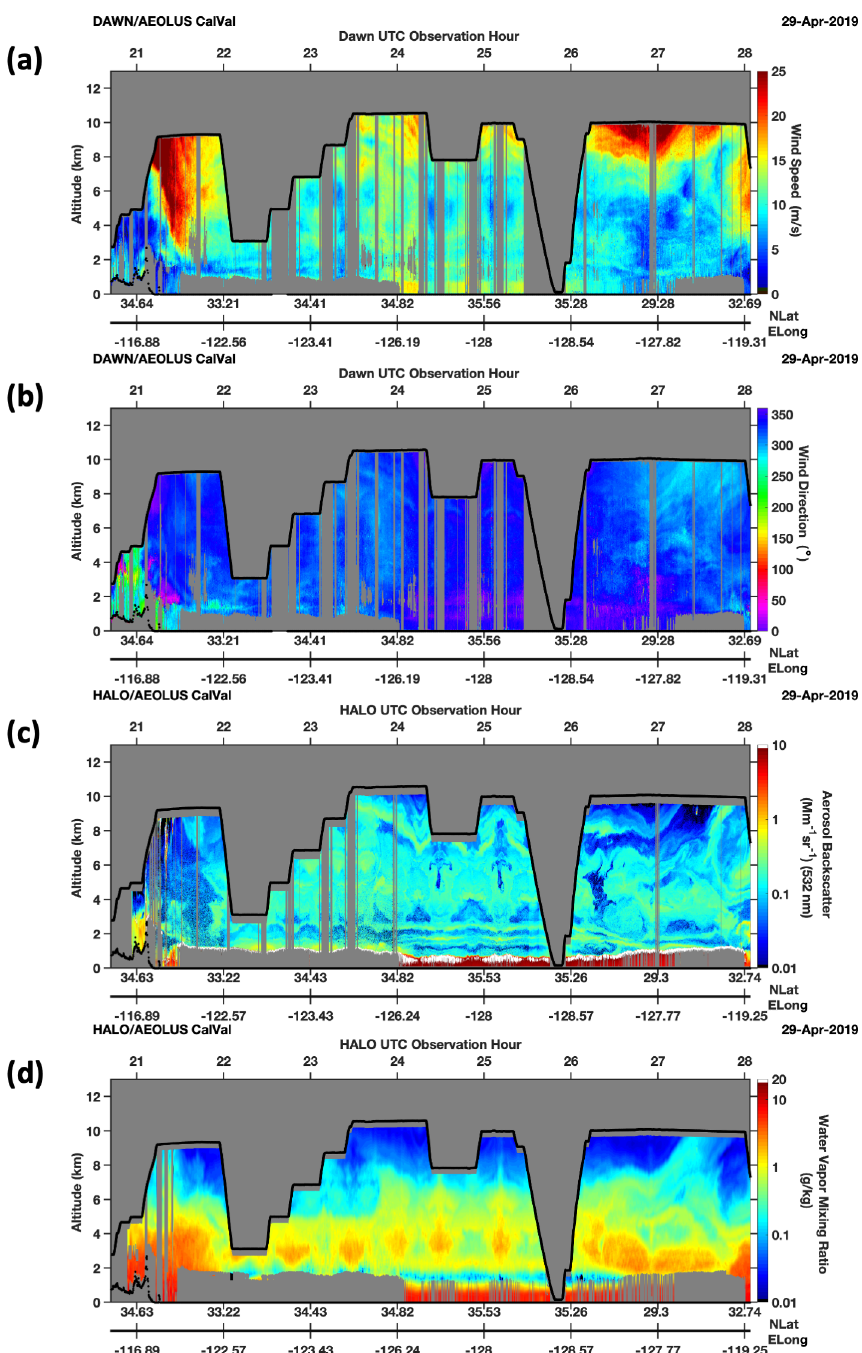
Figure 13. The same as Fig. 6 except for the 29 and 30 April 2019 flight. The color scale of the DAWN wind speed is compressed to 0 to 25ms − 1 to accentuate the lower wind speeds observed during this